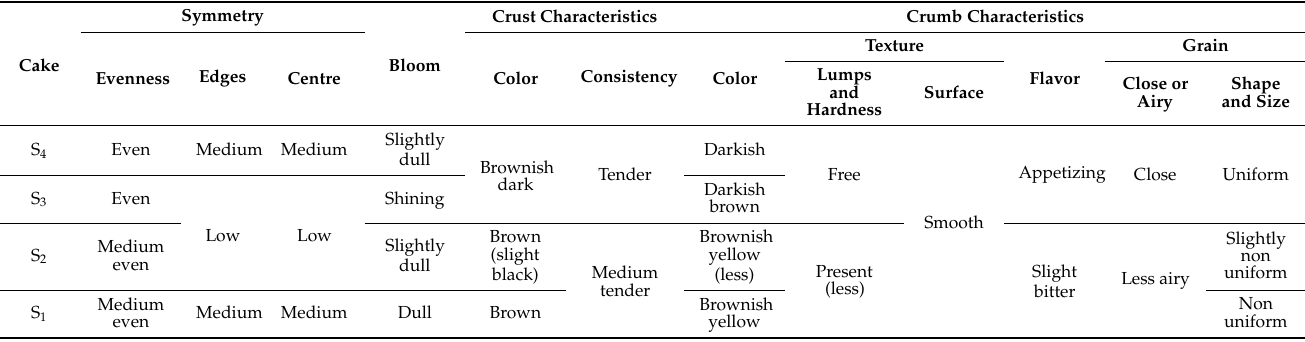
Table 4. Effect of addition of Aloe Vera leaf powder (ALP) on symmetry, crust, and crumb characteristics of plain cakes. Crust Characteristics Crumb Characteristics Cake